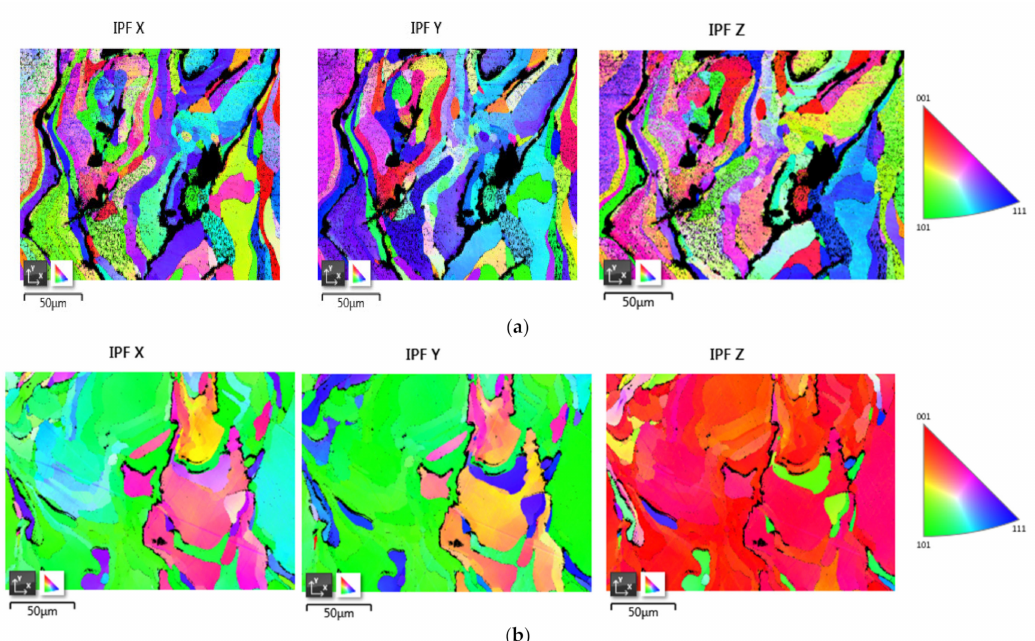
Figure 4. ( a ) EBSD inverse pole figure (IPF) orientation map of sample one is shown in figures. The IPF coloring is the plane’s normal direction parallel to X, Y, and Z direction. ( b ) EBSD inverse pole figure (IPF) orientation map of sample 2 is shown in figures. The IPF coloring is the plane’s normal direction parallel to X, Y, and Z direction.